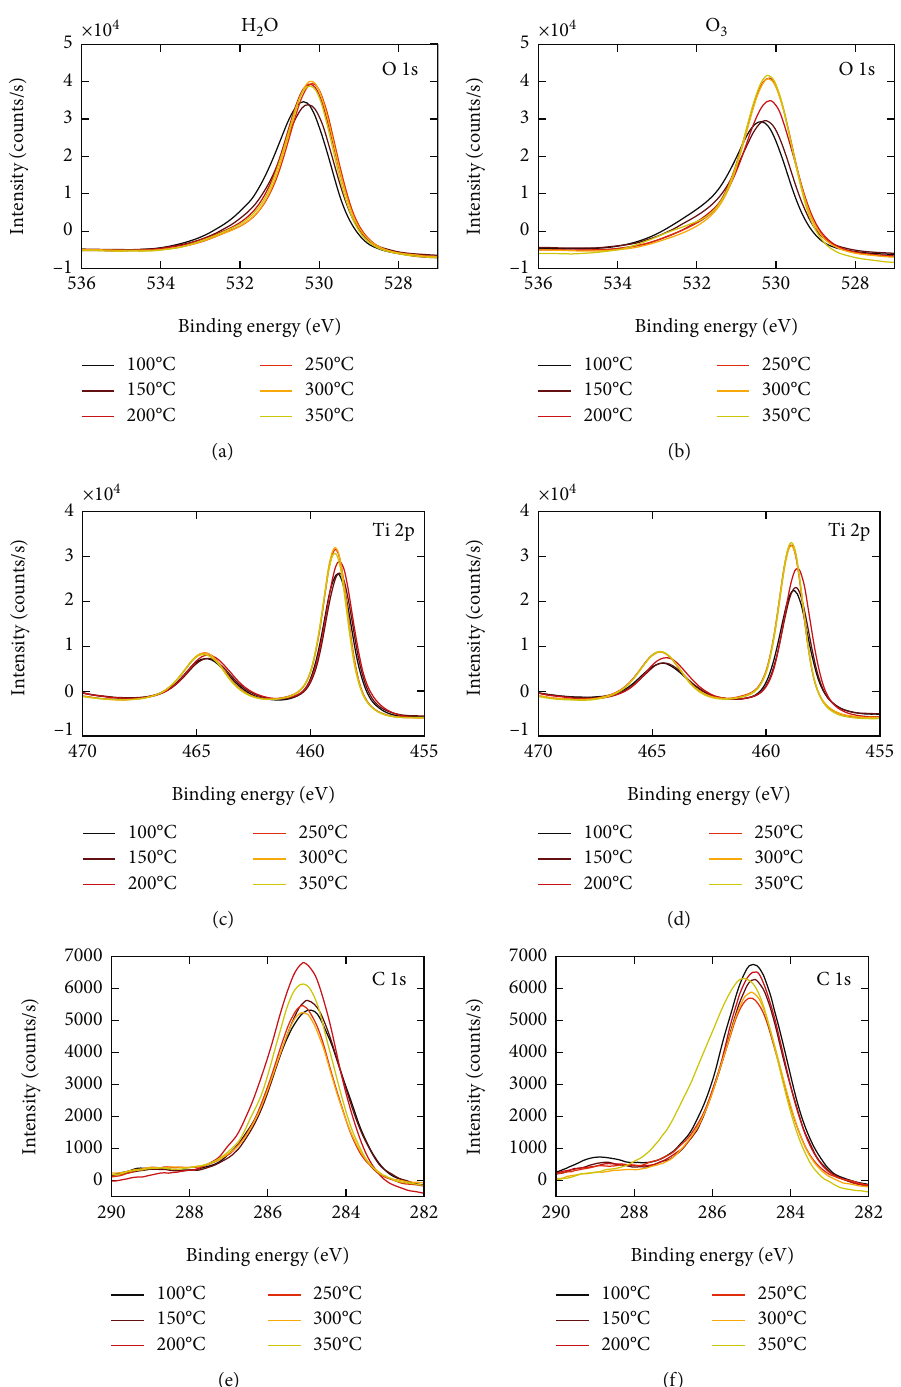
Figure 2: XPS detailed scans of Ti 2p, O 1s, and C 1s of TiO temperatures and 1000 deposition